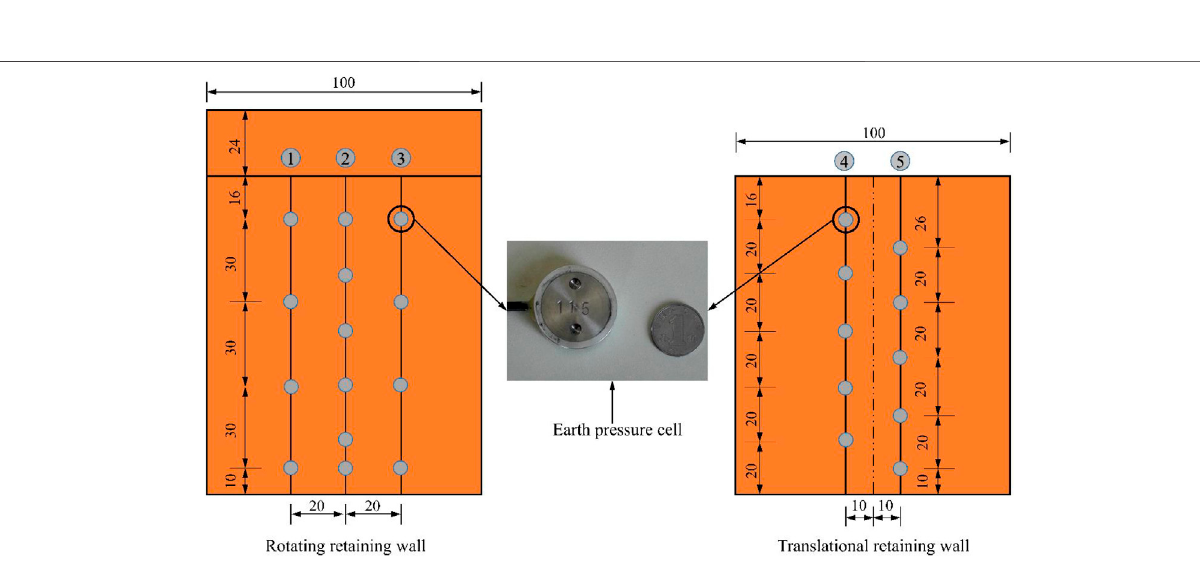
FIGURE 1 | Model box diagram: (A) Upper model box. (B) Lower model box. (C) Side view of the lower model box. (D) Top view of the lower model box.